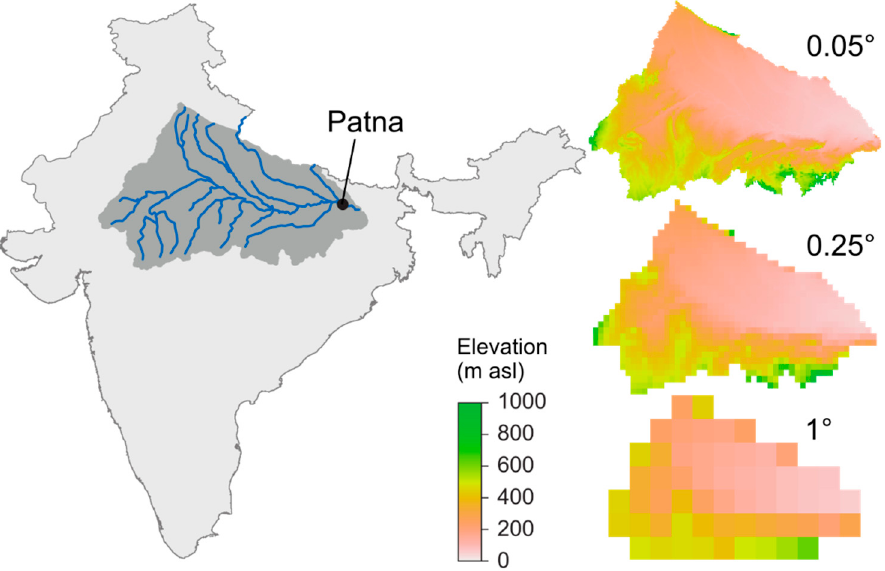
Figure 2. Model extent and SRTM land surface elevation data [54] aggregated to the three model grid resolutions.